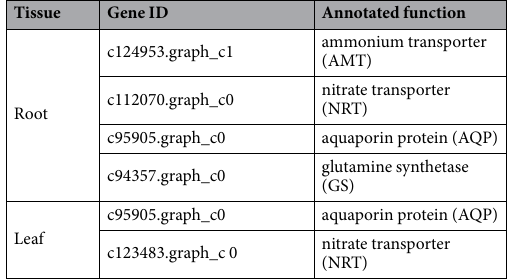
Table 2. Differentially expressed genes shared in two Camellia varieties. DEGs were involved in the process of the transport and assimilation of ammonium in both Camellia varieties. The gene ID is the name of the unigene in the assembly of the Camellia variety